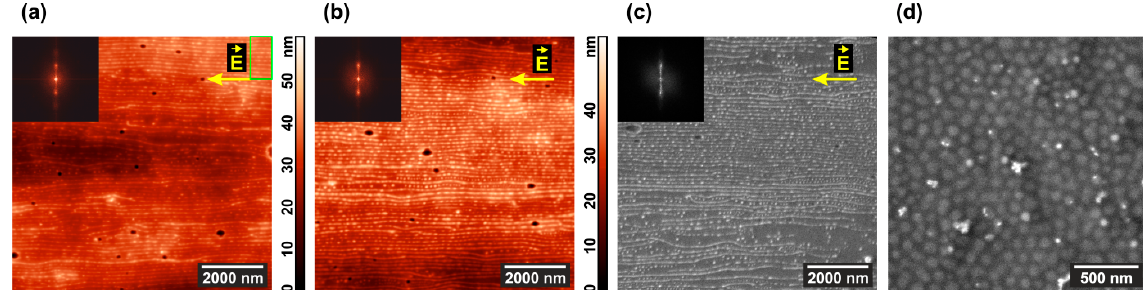
Figure 5. ( a , b ) AFM and ( c , d ) SEM images of the microphase-separated PS–P4VP/AuNR film annealed under chloroform vapor and DC field ( a ) before and ( b – d ) after its exposure to iodine vapor. The insets show fragments of Fourier transforms of the corresponding topographies.